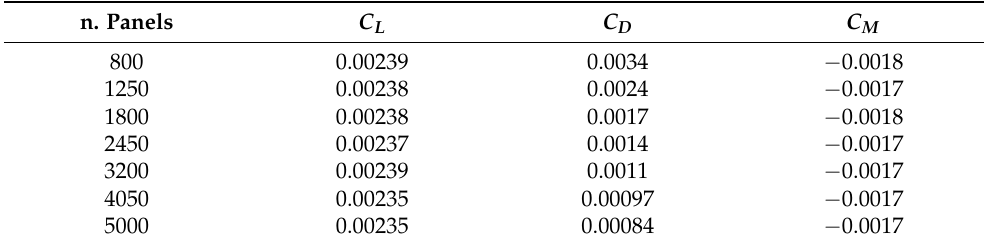
Table A3. ONERA M6 wing geometric data.